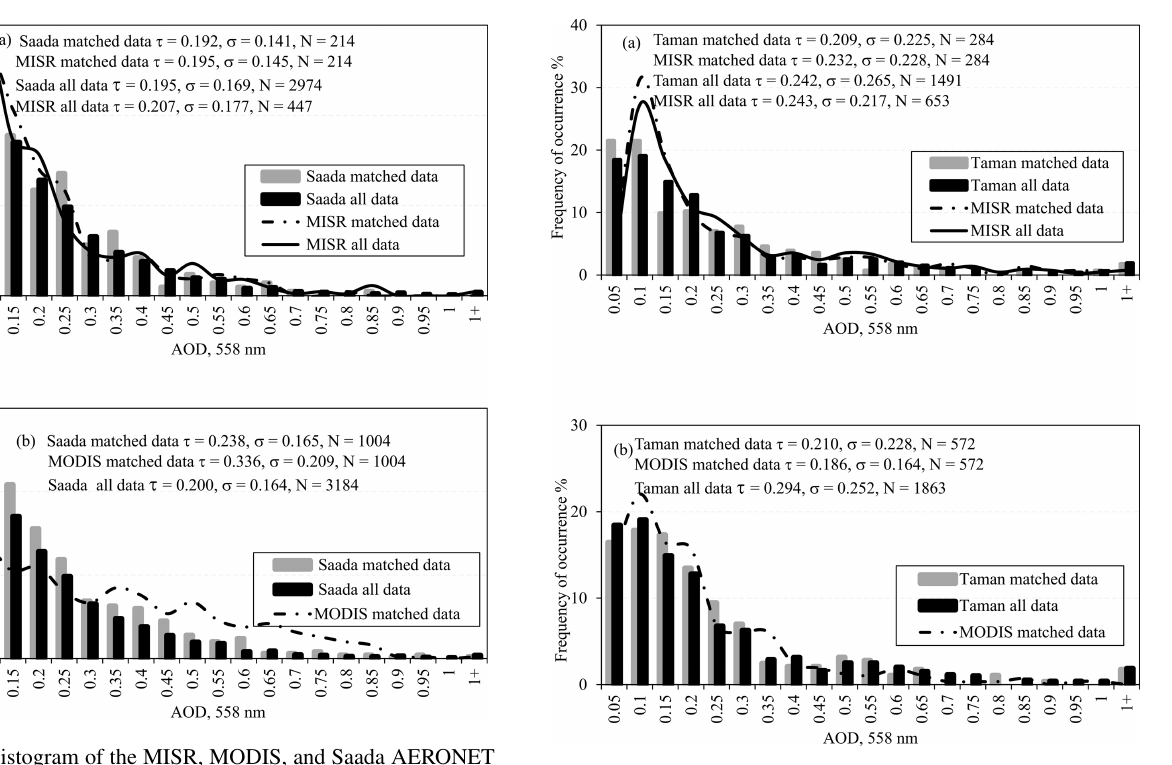
AERONET measurements (a) MISR and (b) MODIS data re-